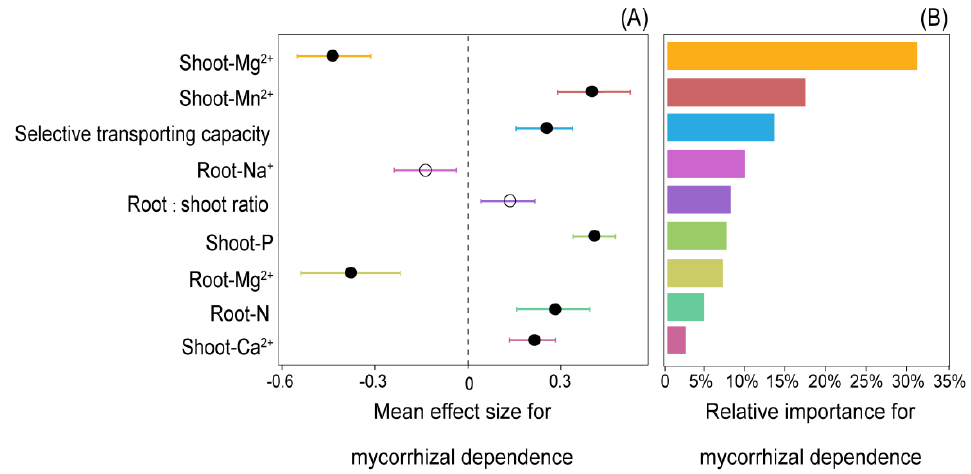
Figure 5. Mean effect sizes of observed variables on mycorrhizal dependence ( MD ) ( A ) and their relative contributions to variances of MD ( B ) in Cinnamomum camphora following partial regression. Abbreviations are as follows: shoot − Mg 2+ , Mg 2+ concentration in shoot; shoot − Mn 2+ , Mn 2+ concentration in shoot; STC , selective transporting capacity of K + over Na + from roots to shoots; root − Na + , Na + concentration in root; shoot − P, P concentration in shoot; root − Mg 2+ , Mg 2+ concentration in root; root − N, N concentration in root; shoot − Ca 2+ , Ca 2+ concentration in shoot.